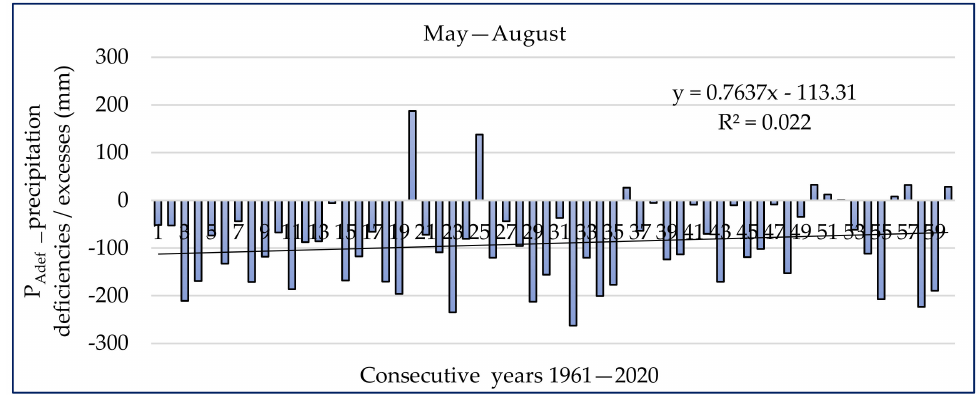
Figure 5. Variability over time of the agricultural drought index (P Adef ) during the period of active plant growth and development in the region of Bydgoszcz (May–August) in 1961–2020.